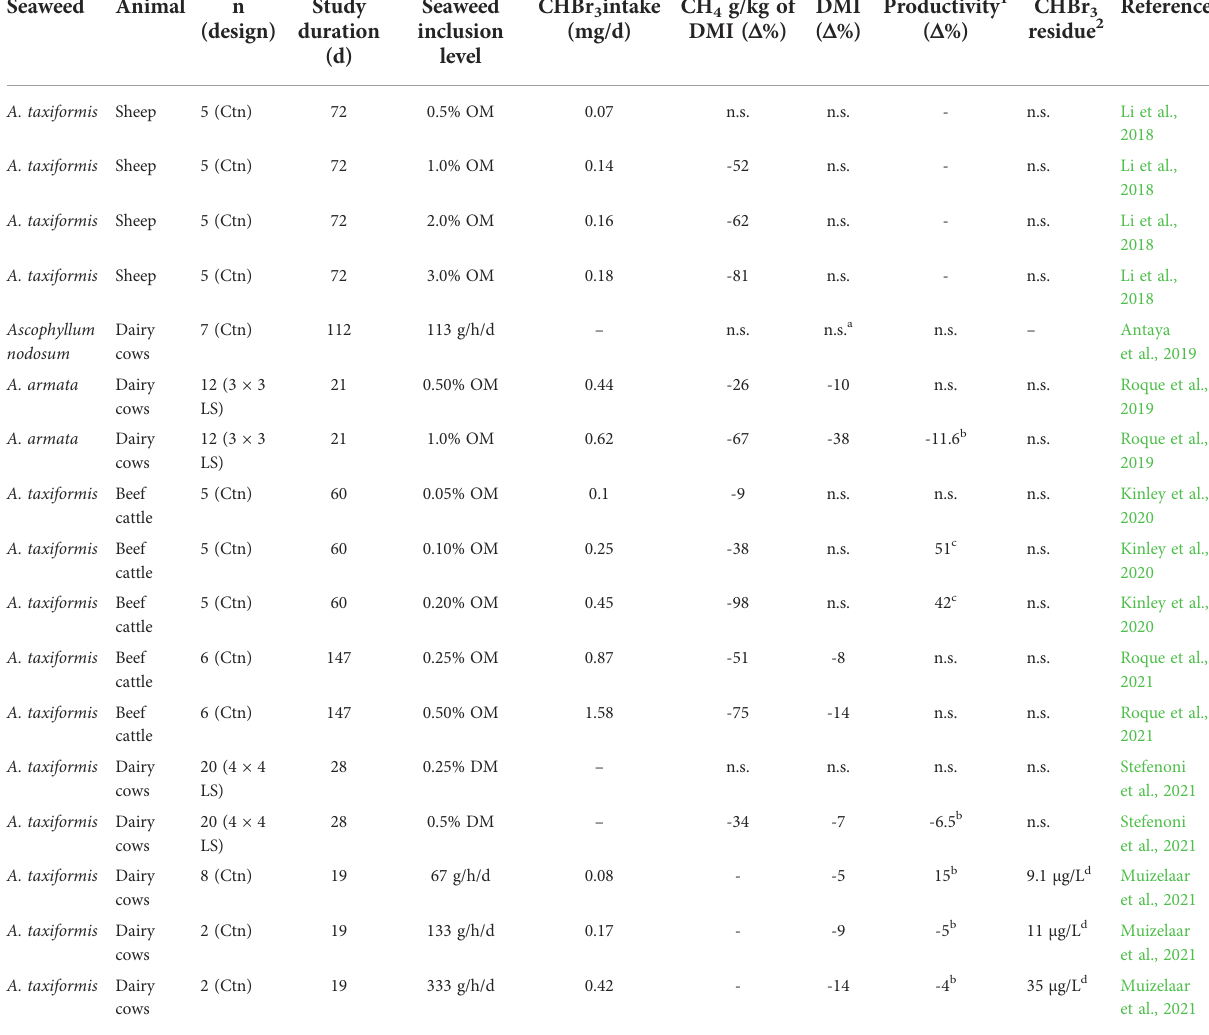
TABLE 1 Summary of in vivo seaweed studies, in which enteric CH 4 emission was measured. . Seaweed